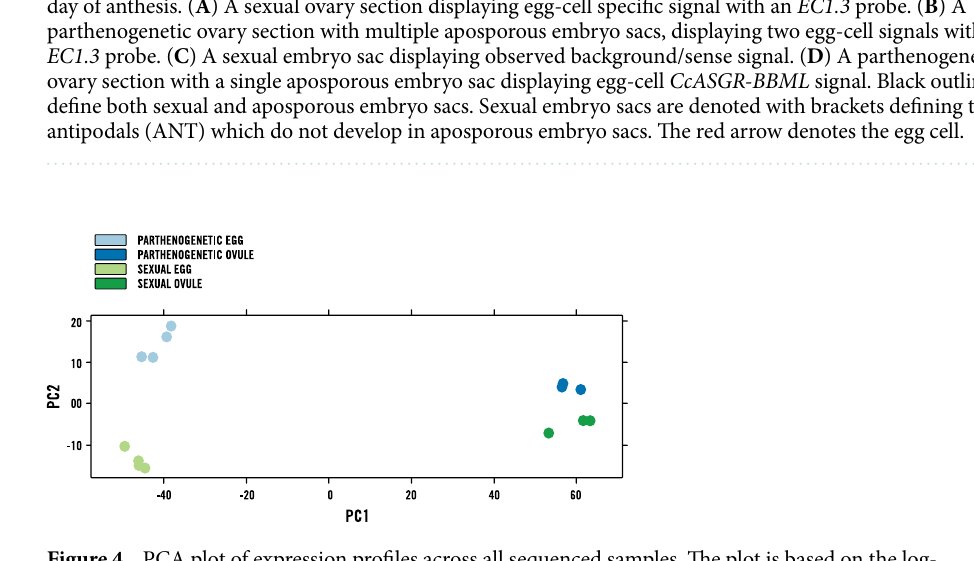
maize, sorghum, rice and sugarcane greatly increases embryogenic potential thereby enhancing transformation